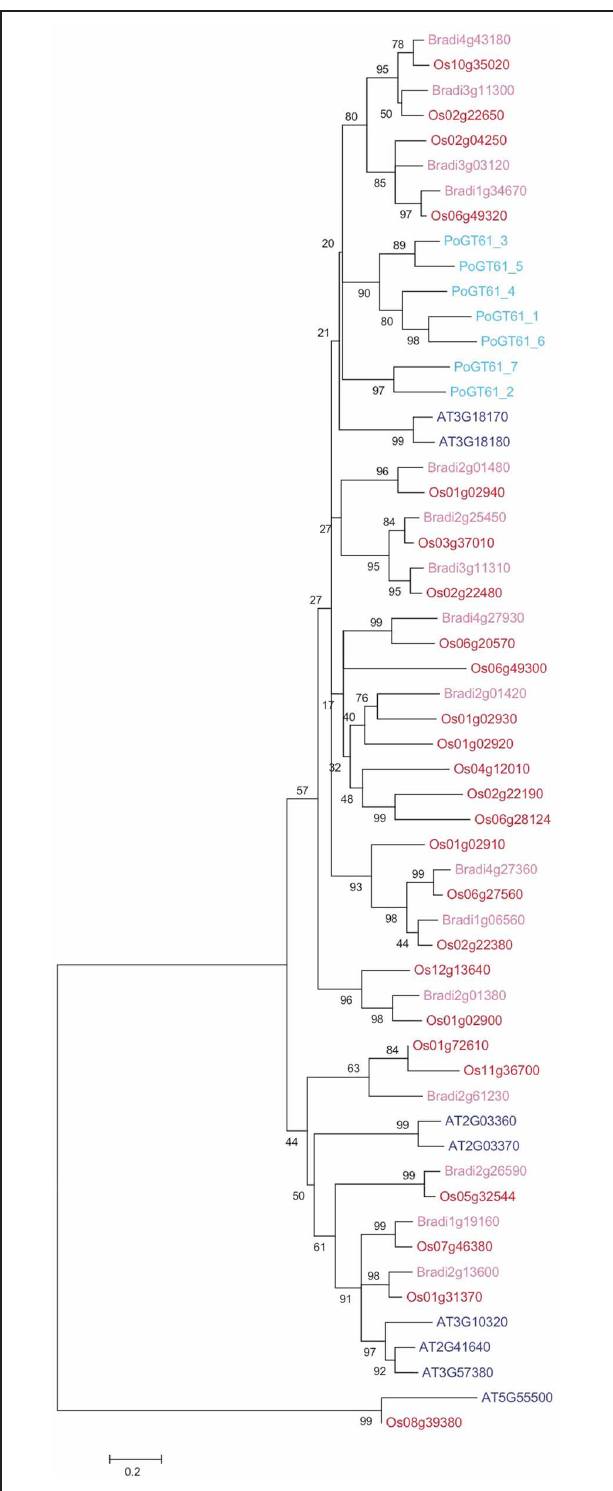
FIGURE 5 | Phylogenetic analysis of glycosyltransferase family 61 proteins from psyllium, Arabidopsis, rice and Brachypodium distachyon . Seven cDNAs displaying homology to At3g18170 and At3g18180 were cloned from psyllium mucilaginous layers and